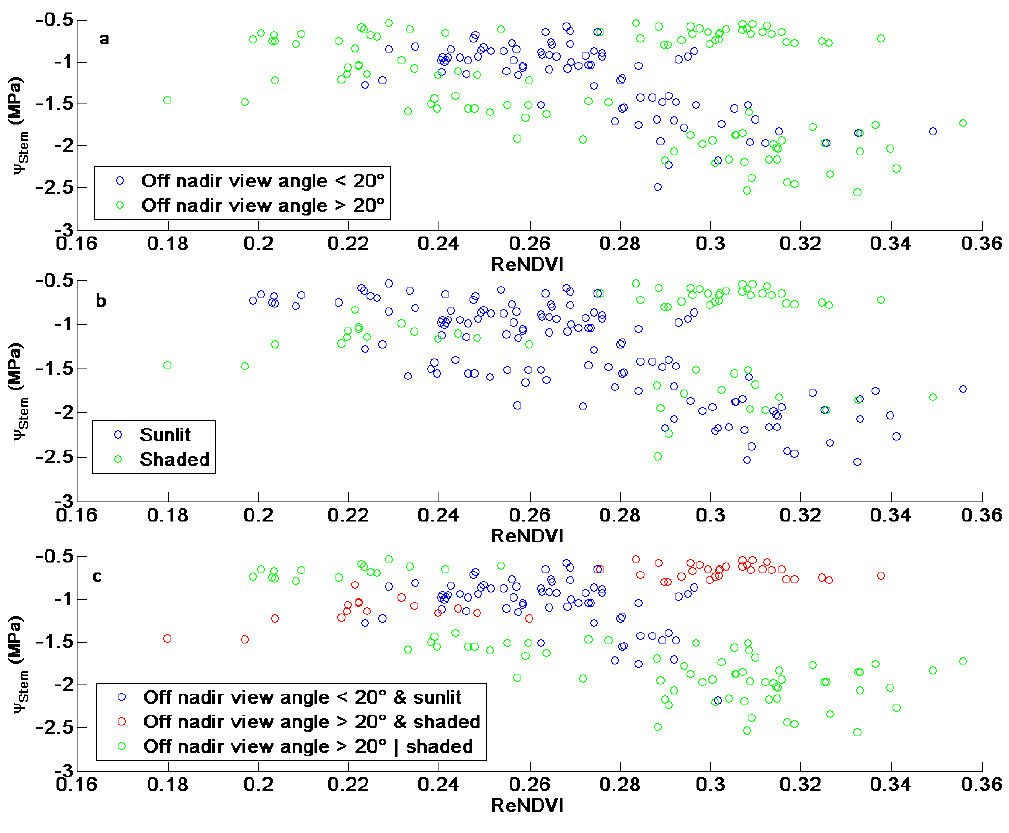
Figure 8. Red edge Normalized Difference Vegetation Index (ReNDVI; Equation (4)) against measured stem water potential ( Ψ ; MPa) for the satellite level, labeled for stem off-nadir viewing angle of the sensor ( a ), scene light conditions based on the sensor’s relative azimuth ( b ) and a combination of both ( c